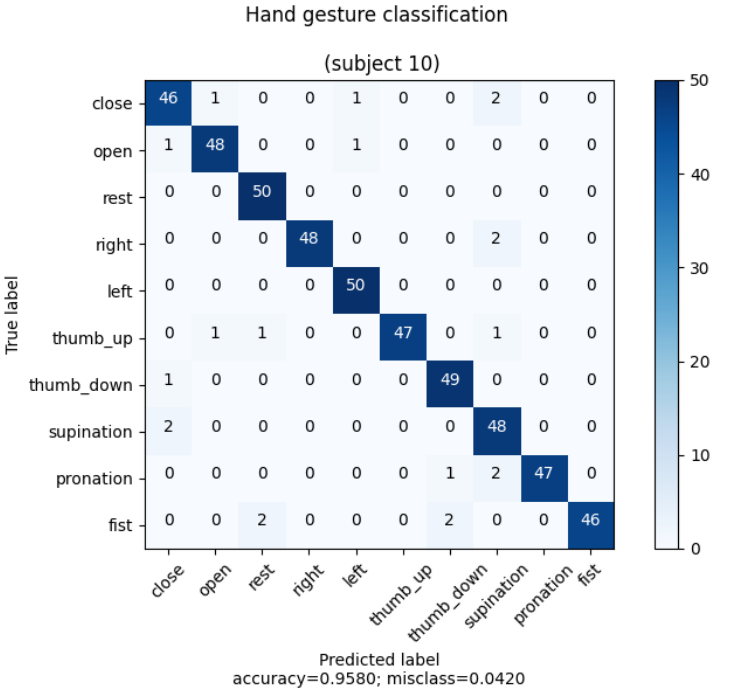
Figure A10. Confusion matrix of a subject who did not participate in data collection (subject